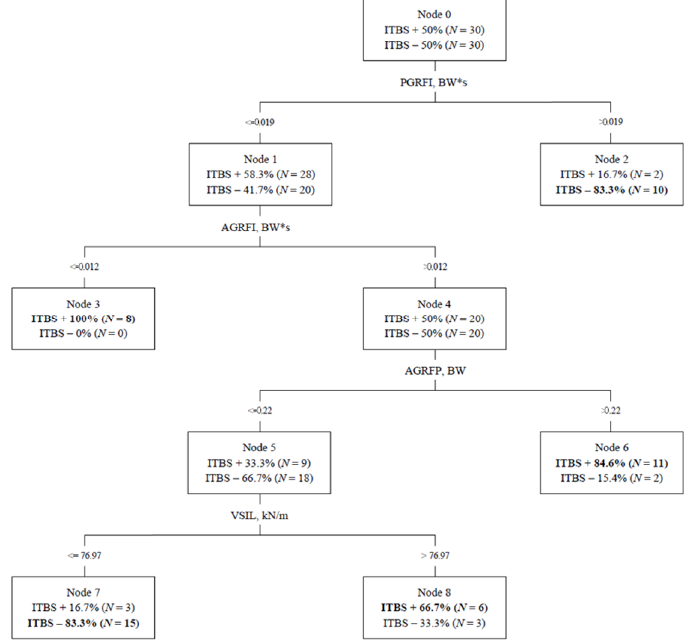
Figure 1. Classification and regression tree model for iliotibial band syndrome. ITBS, iliotibial band syndrome; PGRFI, posterior ground reaction force impulse; AGRFI, anterior ground reaction force impulse; AGRFP, anterior ground reaction force peak; VSIL, vertical stiffness at initial loading. Classification profiles for runners with ITBS. Node 3: PGRFI <= 0.019 BW*s, AGRFI <= 0.012 BW*s. Node 6: PGRFI <= 0.019 BW*s, AGRFI > 0.012 BW*s, AGRFP > 0.22 BW. Node 8: PGRFI <= 0.019 BW*s, AGRFI > 0.012 BW*s, AGRFP <= 0.22 BW, VSIL > 76.97 kN/m. Classification profiles for runners